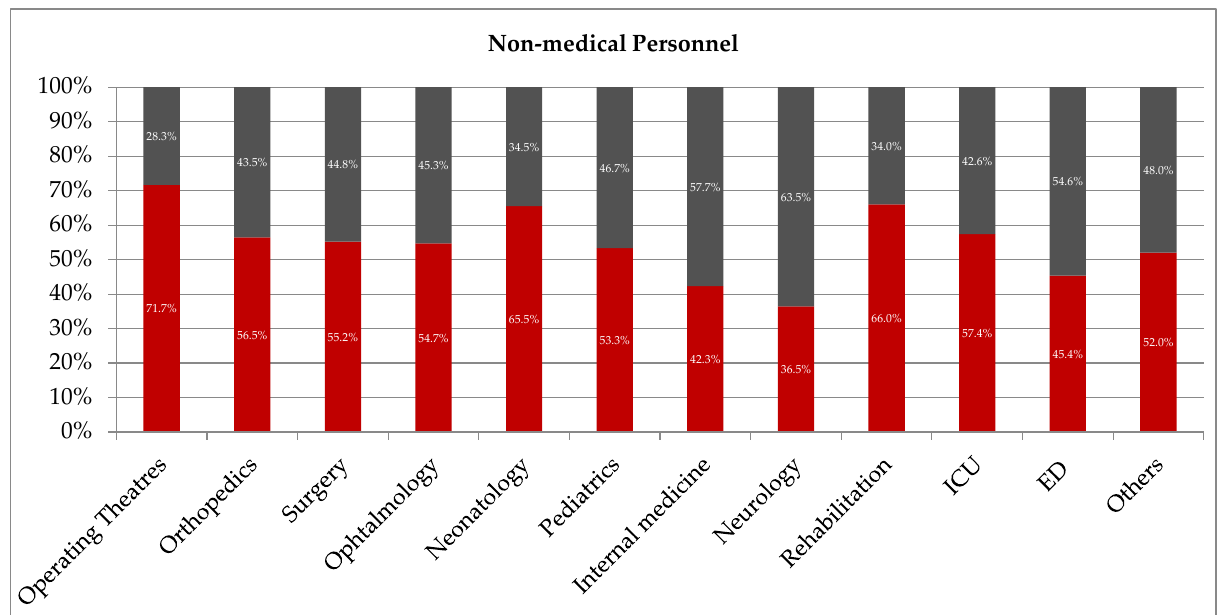
Figure 3. The frequency of adherence to the BBE policy depends on the personnel’s profession and place of work (other — administration, radiology, laboratory, pharmacy; ICU — intensive care unit; ED — emergency department). Black color — non-BBE group; red color — BBE group.